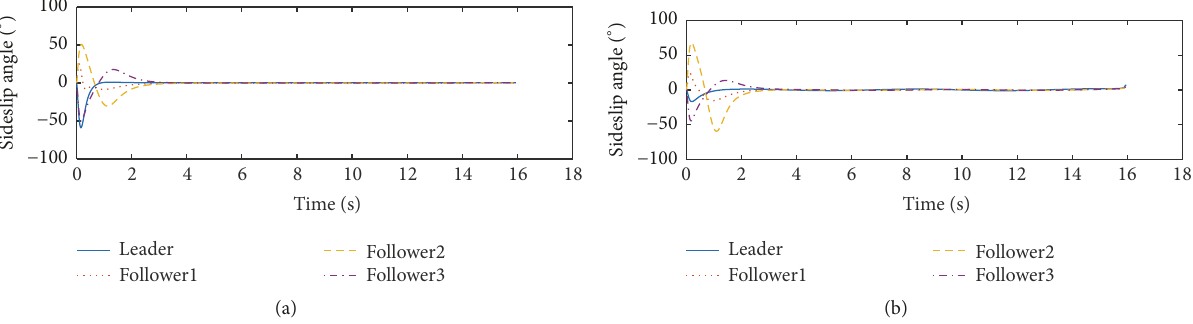
Figure 13: Comparison of the interceptor’s sideslip angle curves in the design methods with and without state coupling: (a) sideslip angle curve in the design method with state coupling; (b) sideslip angle curve in the design method without state